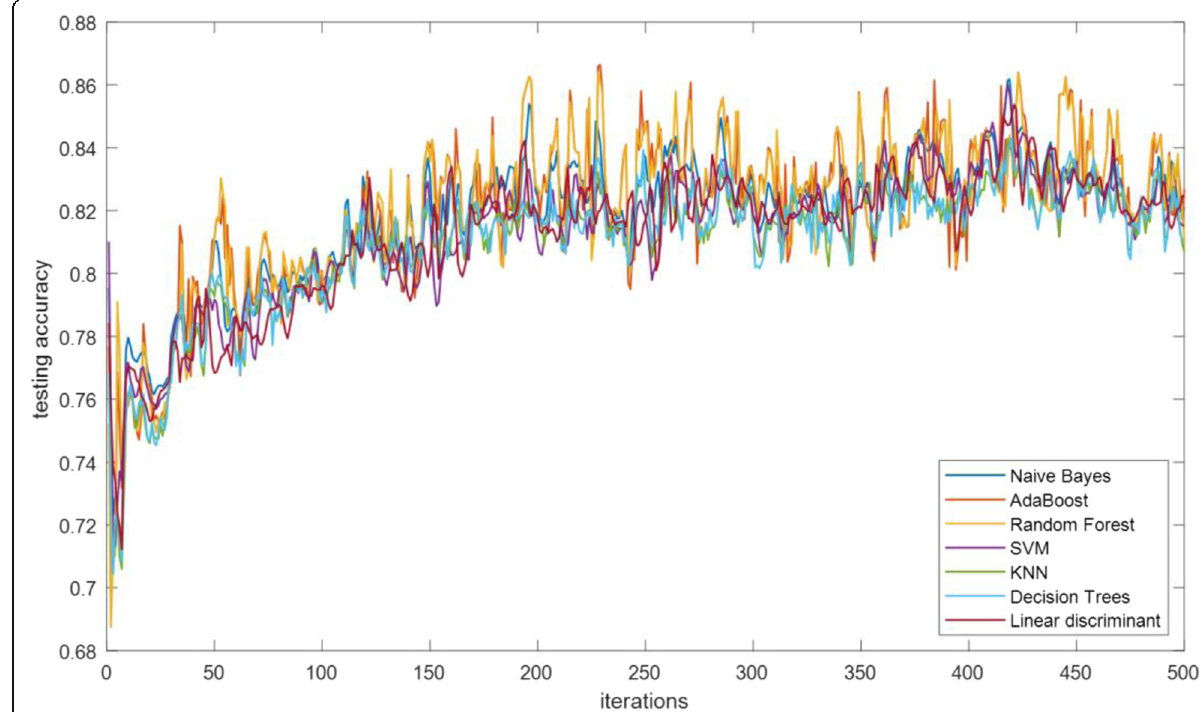
Fig. 6 Testing accuracy with respect to number of iteration of different ML models trained on the resulted 1-d feature